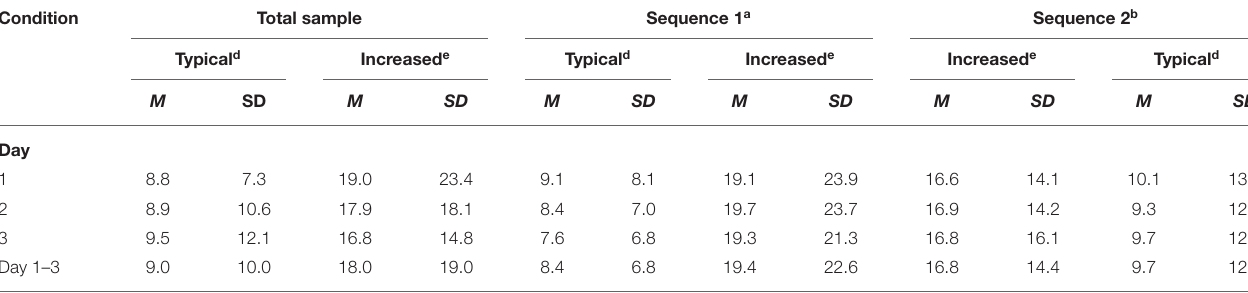
TABLE 2 | Amount of checking in the typical checking and increased body checking condition.